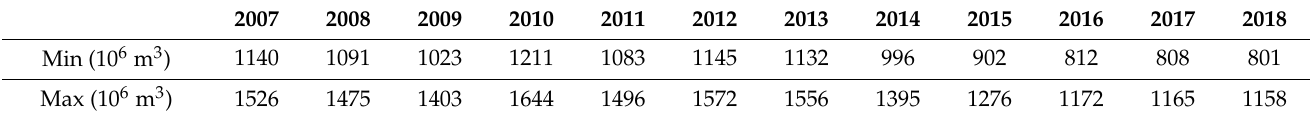
Table 1. Total expected agriculture water demand for